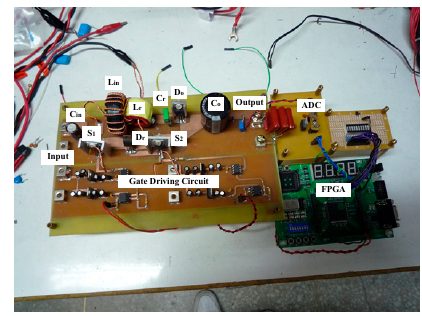
Figure 18. Photo of the experimental setup.